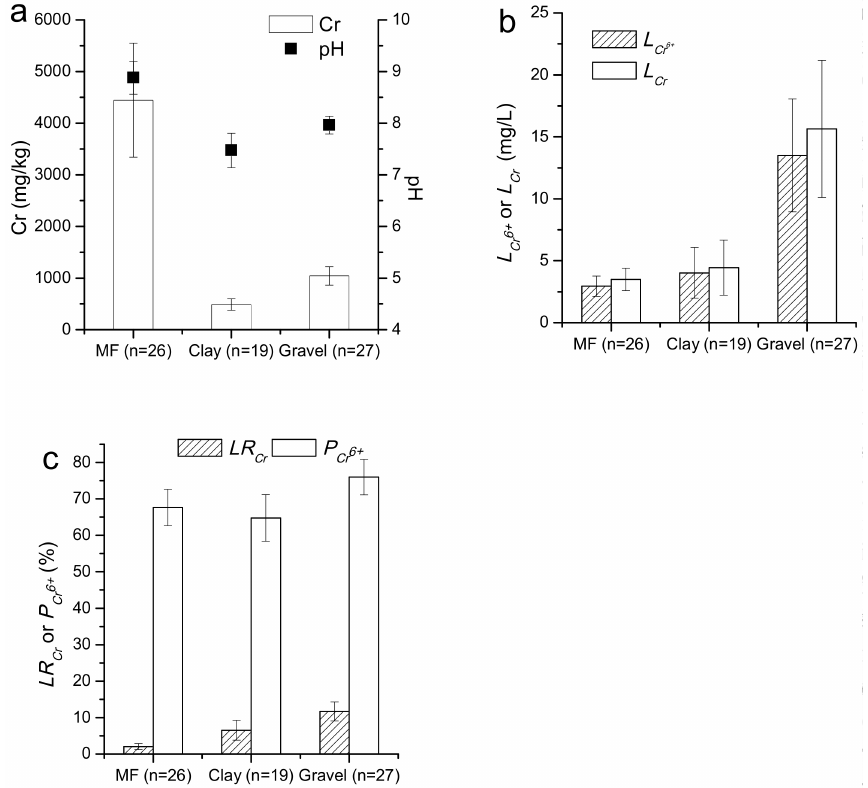
Figure 4. The Cr concentration and pH ( a ), L Cr and L Cr 6+ ( b ), LR Cr and P Cr6+ ( c ) of the different soil layers. MF: Miscellaneous